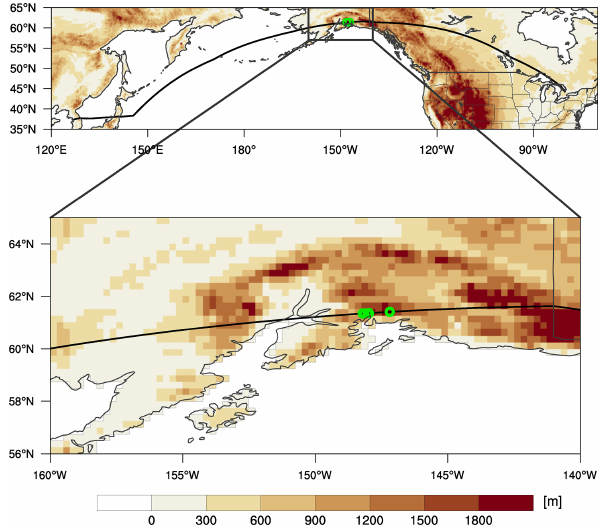
Figure 14. Flight route (line) and horizontal locations (circle) of MOG-level turbulence events detected from the QAR data on De- cember 2012 (from 02:53 to 15:07UTC on 30 December), with a horizontal distribution of terrain height of 5min digital elevation model